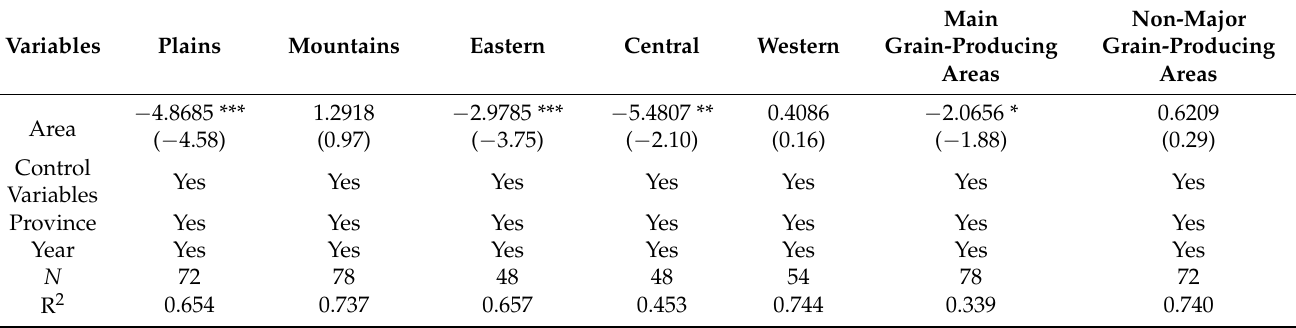
Table 6. The estimation results of different topographic areas, economic belts, and grain production areas.